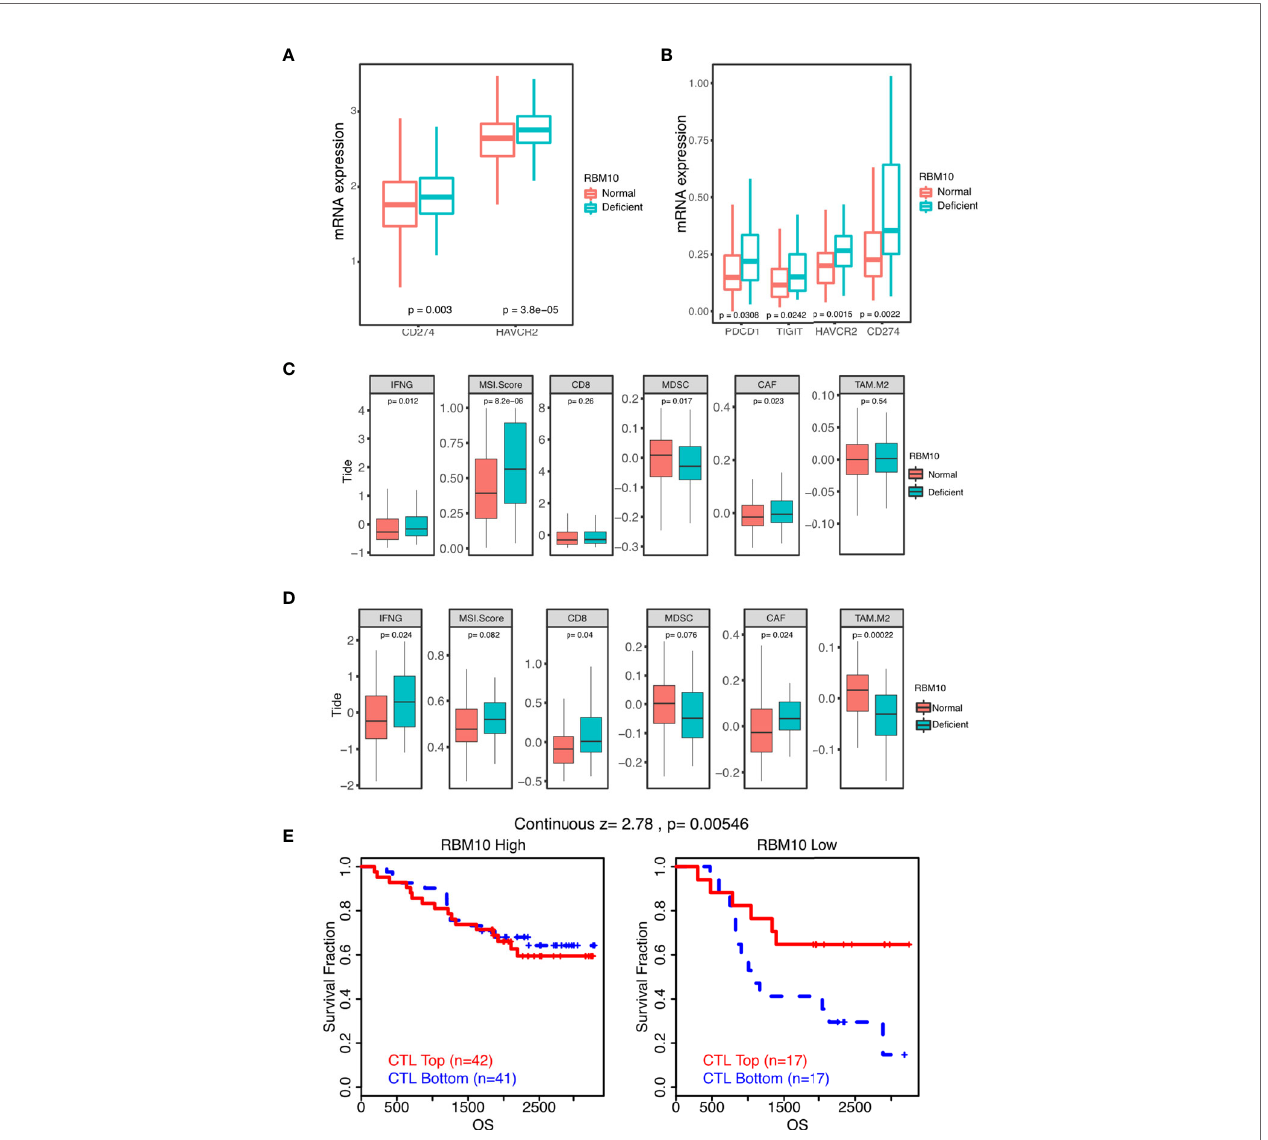
FIGURE 6 | RBM10 de fi ciency is associated with many immune markers. (A, B) Quantitative analysis of mRNA expression of immune checkpoint molecules of between RBM10 de fi cient LUADs and those with normal expression in TCGA_LUAD (A) and CHOICE_ADC (B) cohorts. (C, D) Several predicted TIDE scores are dysregulated in RBM10 de fi cient LUADs in both TCGA_LUAD (C) and CHOICE_ADC (D) cohorts. (E) The impacts of RBM10 expression on the effect of cytotoxic T lymphocytes based on survival data of a Japanese LAUD cohort from online website of